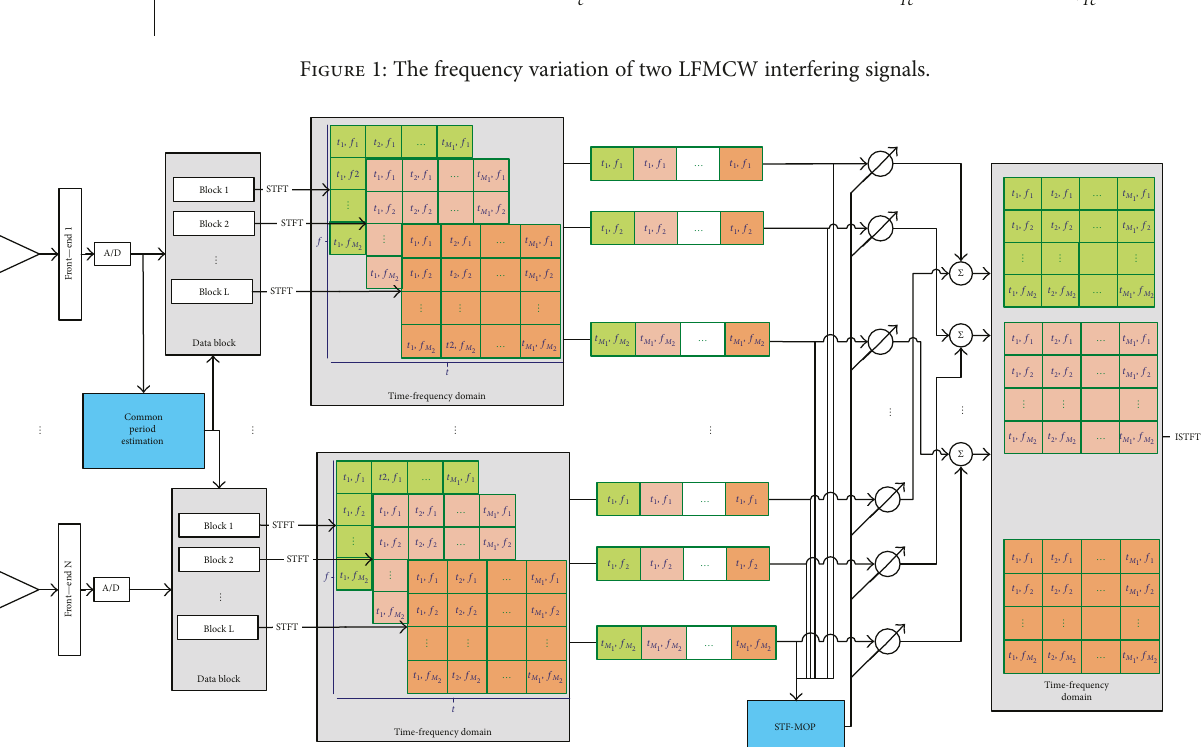
Figure 2: The diagram of the proposed